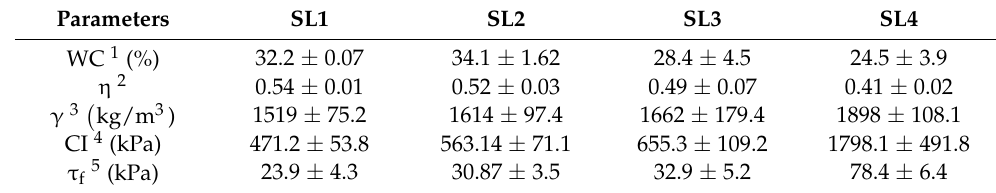
Table 5. Results of measurement of soil properties according to soil layers in loam (second site).